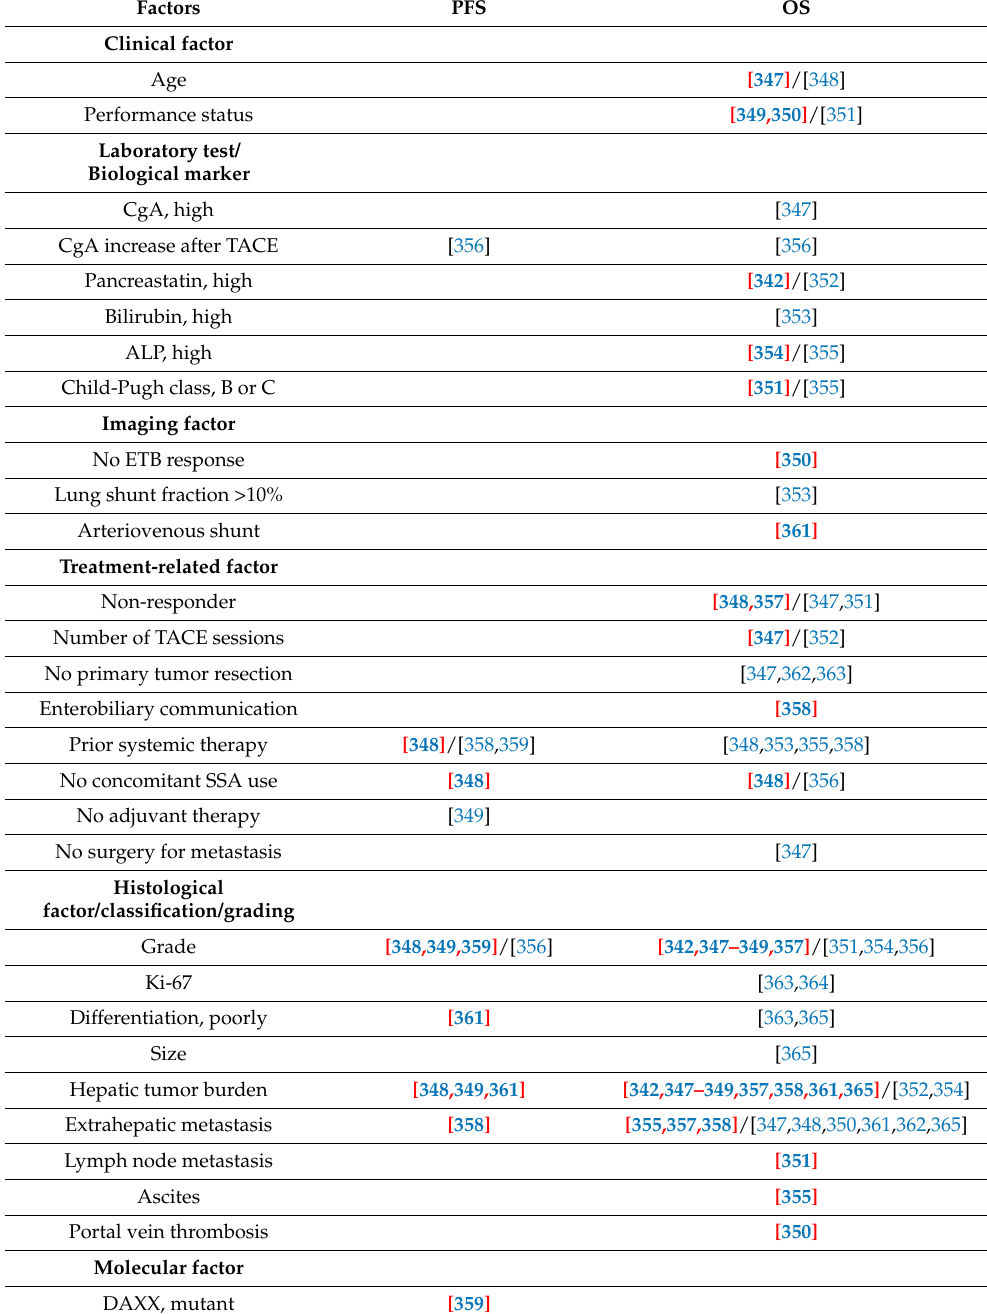
Table 5. Factors associated with worse PFS and OS with liver-directed therapy in advanced